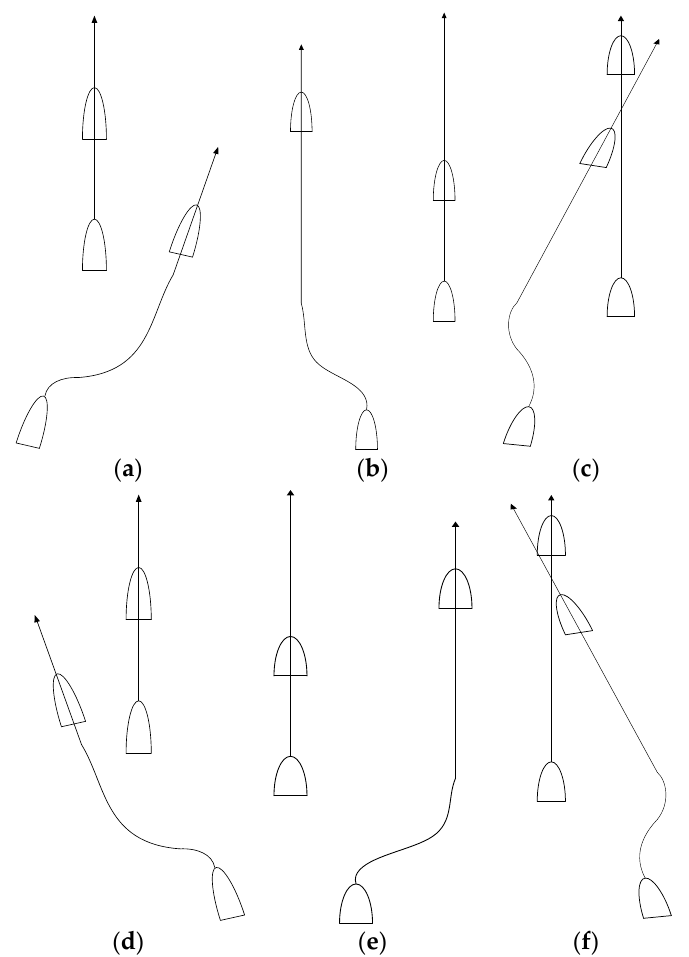
Figure 4. Overtaking situation ( a ) DCPA > 0 and θ T ∈ [7 π / 6, 11 π / 8], ( b ) θ T ∈ [7 π / 6, 11 π / 8] and φ O = φ T, ( c ) DCPA ≤ 0 and θ T ∈ [7 π / 6, 11 π / 8], ( d ) DCPA < 0 and θ T ∈ [5 π / 8, 7 π / 6], ( e ) θ T ∈ [5 π / 8, 7 π / 6] and φ O = φ T , and ( f ) DCPA ≥ 0 and θ T ∈ [5 π 8, 7 π / 6].